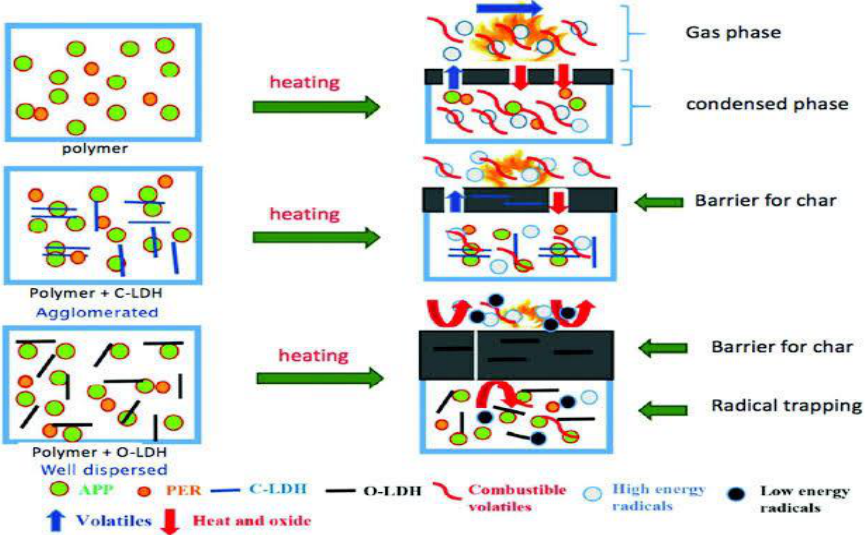
Figure 7. Dual fire-retardant action “Reprinted with permission from Ref. [123]. 2017, American Chemical Society.’’ .